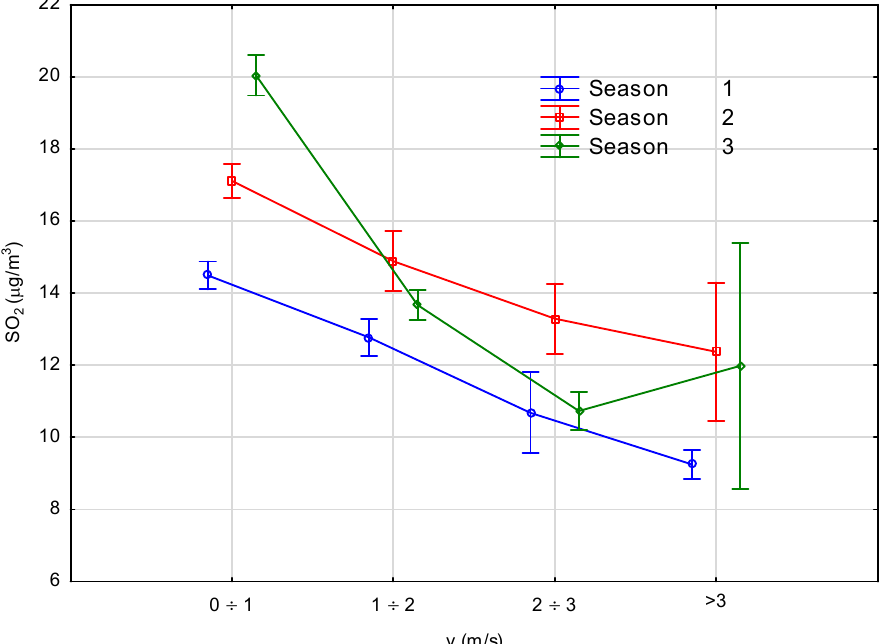
Figure 6. Relation between PM 10 concentration and temperature for the analyzed heating seasons.